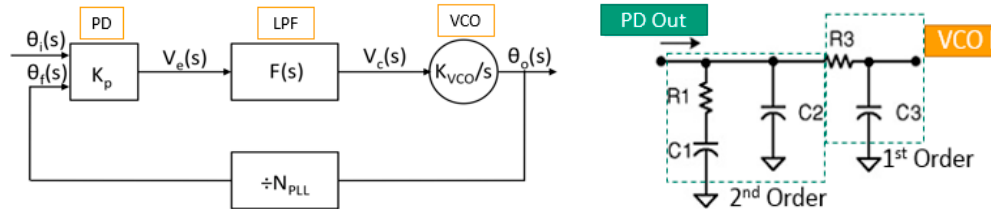
Figure 3. Block diagram representation of a PLL ( left ) and third order PLL loop filter governing representing F(s) ( right ) ([25]).